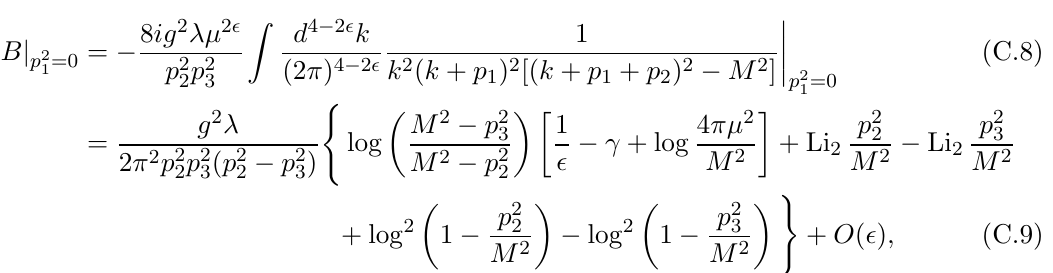
Figure 5 . Relevant diagrams for the 1-loop 3-point function generated by Z 0 and Z 0 are diagrams of G 0 (3) , C is a diagram of G 0 (3) n and D appears in